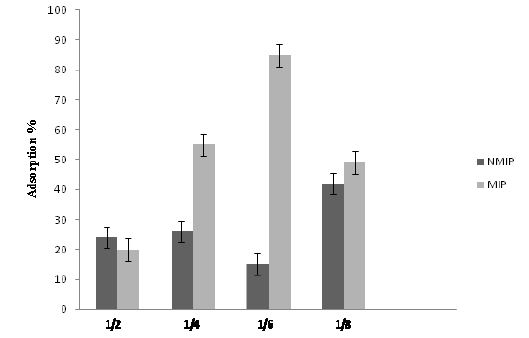
Figure 7. Recovered samples obtained using the MIP and NIP polymers synthesized at different template / monomer ratios (mean±S.D.,